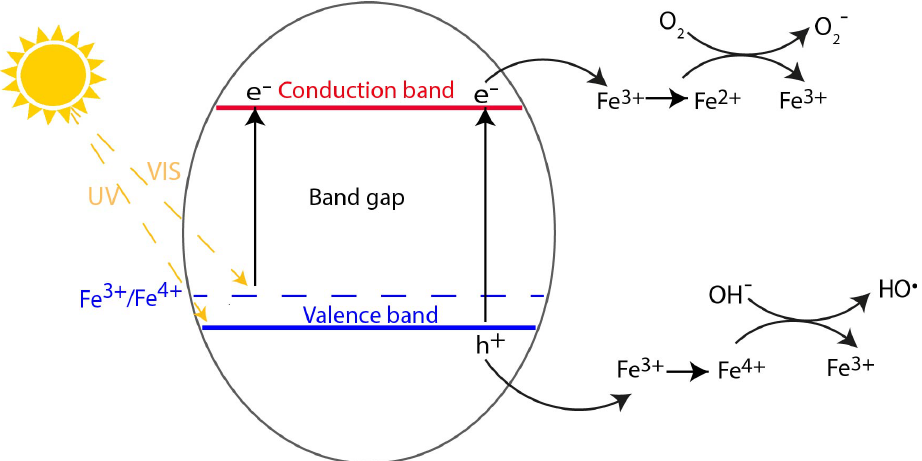
Figure 4. Energy diagram for doping with iron and possible consecutive reaction mechanisms under UV and visible light